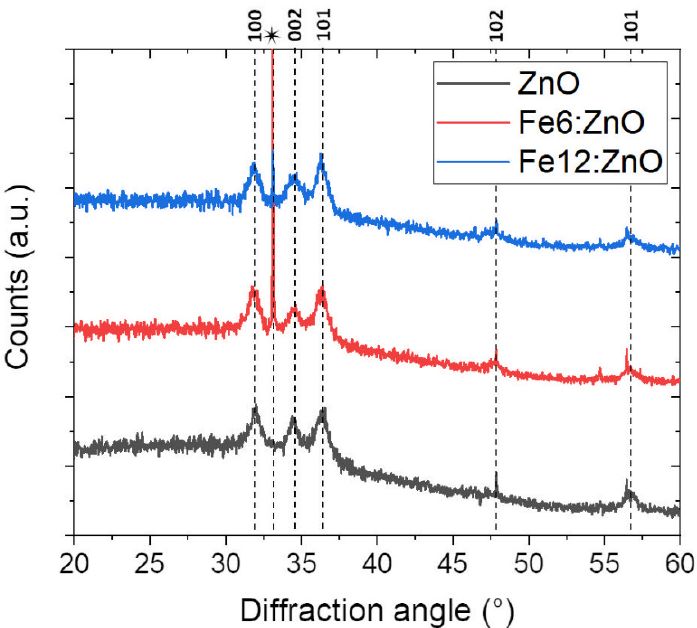
Figure 5. Curve-fitted Fe2p 3/2 spectrum for Fe:ZnO nanoparticles.